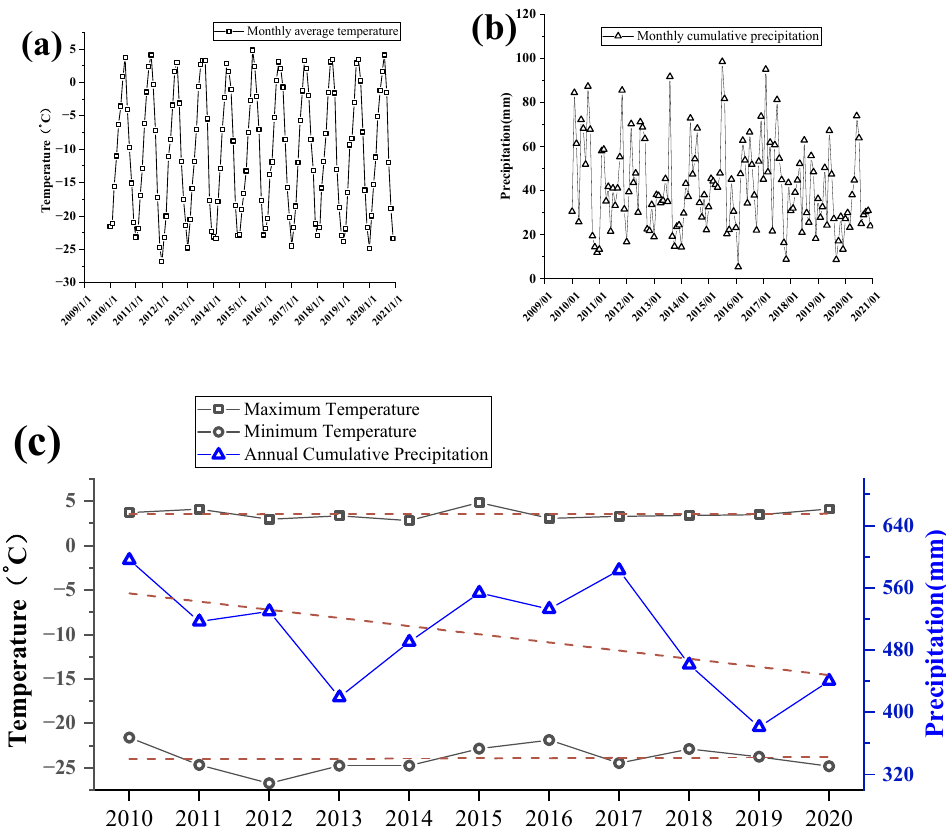
Figure 6. ( a ) Monthly average temperature variation curve in the Karakul Lake basin from 2010 to 2020. ( b ) Monthly cumulative precipitation curves in the Karakul Lake basin from 2010 to 2020. ( c ) Annual temperature extremes and annual cumulative precipitation curves in the Karakul Lake basin from 2010 to 2020.